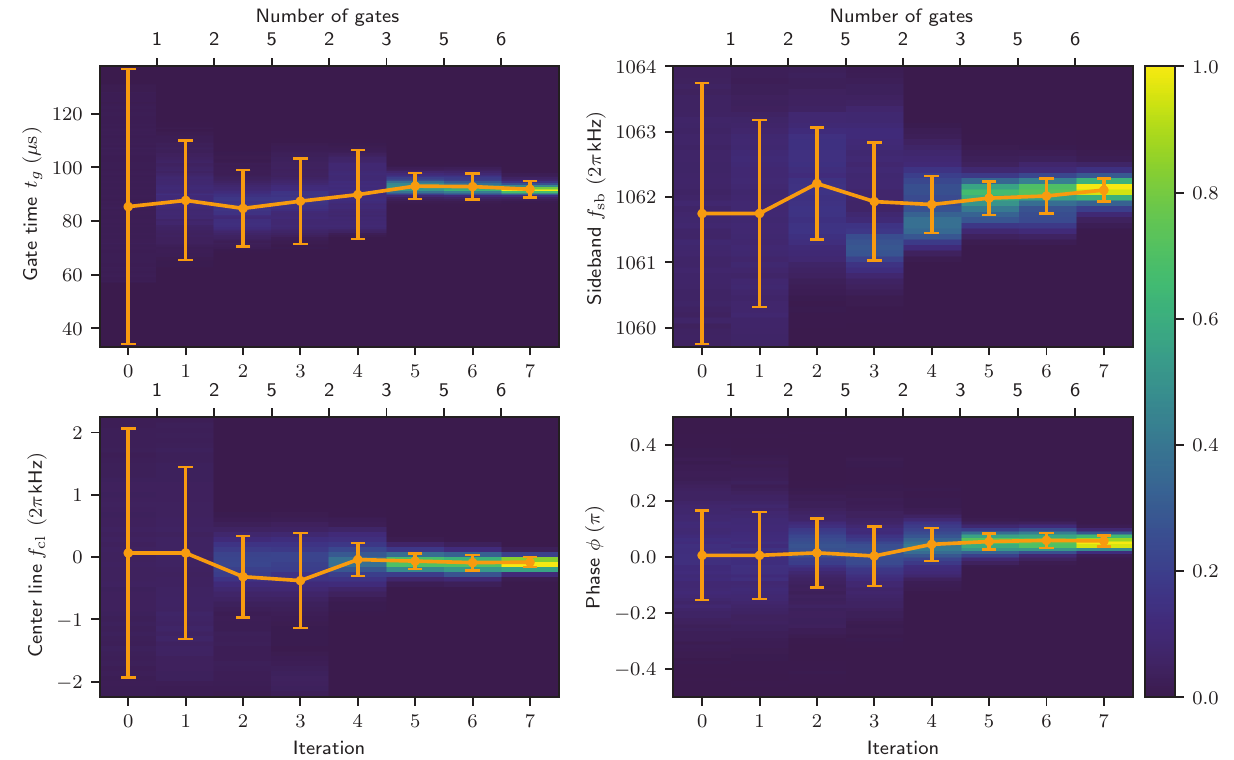
FIG. 4. Projections of the particle filter for the control parameters (cid:3) c at each iteration of a single calibration run. The mean and standard deviation of the probability distribution of the control parameters calculated using the relations in Eqs. (16), (18), (17), and (19) is shown in orange. The probability density of each plot is normalized to its maximum. Each iteration uses the measurement outcomes of 100 repetitions of the experiment to update the probability density. As an initial prior, a Gaussian with widths of σ (cid:8) = = 2 × 2 π kHz center line uncertainty, σ = 2 × 2 π kHz sideband uncertainty, and σ = 0.2 (cid:8) opt Rabi frequency uncertainty, σ ω δ (cid:13)ϕ cl 0.16 π phase uncertainty is chosen, which corresponds to typical experimental uncertainties after preliminary calibration. The marks at the top indicate the length of the gate sequence used for the measurements, chosen according to the variance minimization strategy described in Sec. IV